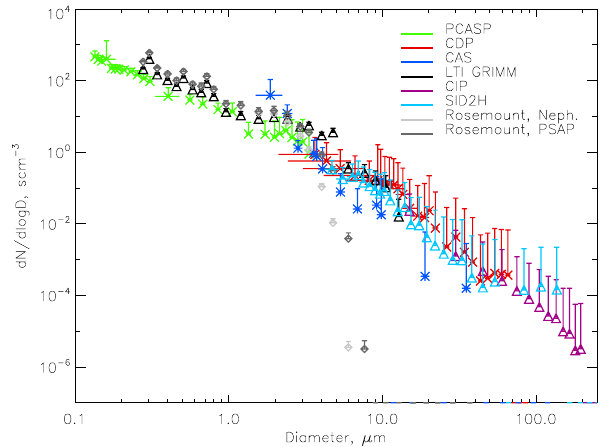
Fig. 3. Size distributions as measured by different instruments dur- ing Fennec 2011 for horizontal legs where all were operational, including refractive index corrections for m =1.53–0.001i. Col- ors represent PCASP (green), LTI-GRIMM (black), CAS (dark blue), SID2H (light blue), CDP (red), CIP (purple). Size distribu- tions reaching the nephelometer (“Neph.” in caption) and PSAP are shown in light grey and dark grey diamonds respectively. This data includes effects of both Rosemount inlets and pipe losses. Verti- cal error bars indicate one standard deviation of the data. Upwards error bars only are shown for clarity. Horizontal error bars show un- certainty due to the non-monotonic relationship of scattering cross- section with particle size from refractive index